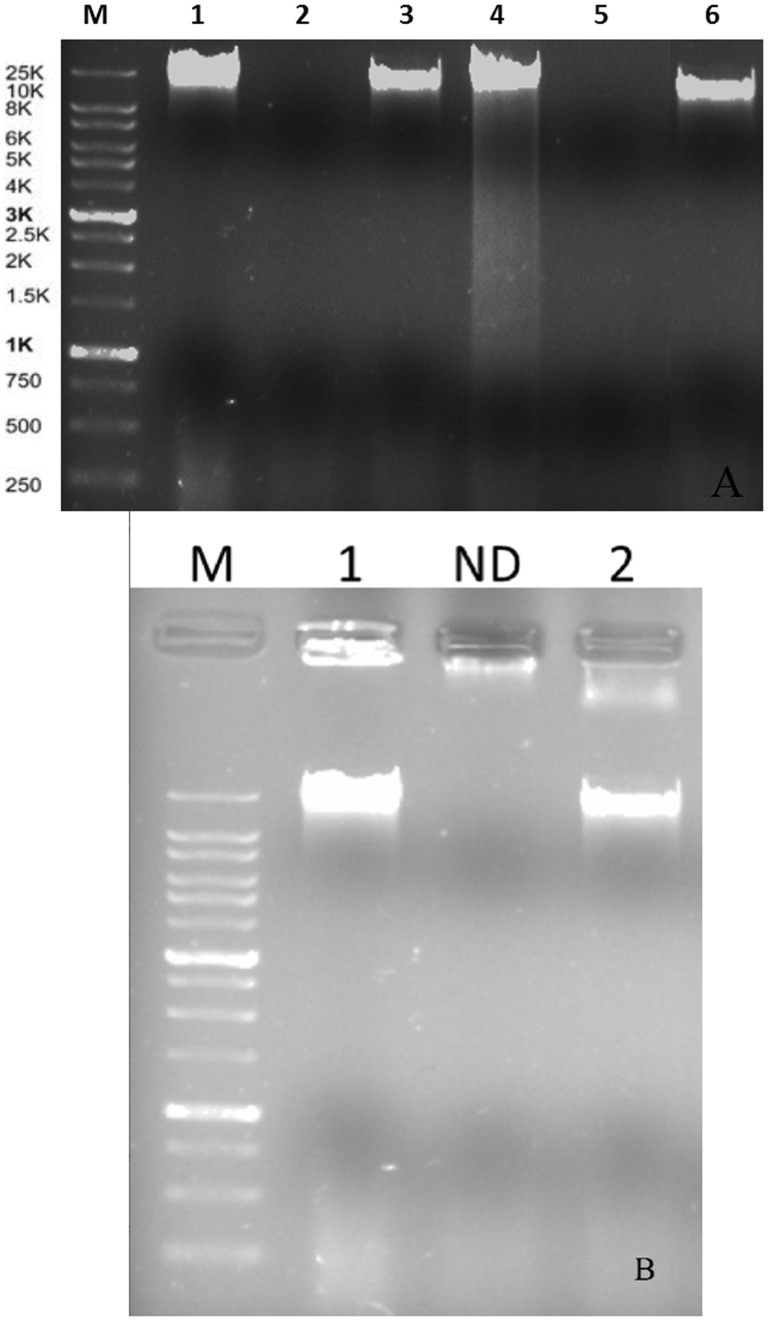
Phage DNA following digestion with DNase I and RNase A (5 µL loaded) (A), Lane M: XXL DNA Ladder GeneOn; Lane 1: uncut VP-2 phage nucleic acid; Lane 2: DNase I digested VP-2 phage nucleic acid; Lane 3: RNase A digested VP-2 phage nucleic acid; Lane 4: uncut VA-1 phage nucleic acid; Lane 5: DNase I digested VA-1 phage nucleic acid; Lane 6: RNase A digested VA-1 phage nucleic acid.Agarose gel (0.8%) showing electrophoretic patterns of S1 Nuclease restriction digestion of phage DNA(B). Lane M: XXL DNA Ladder GeneOn; Lane 1: VP-2 DNA and Lane 2: VA-1 DNA. ND – Not determined.